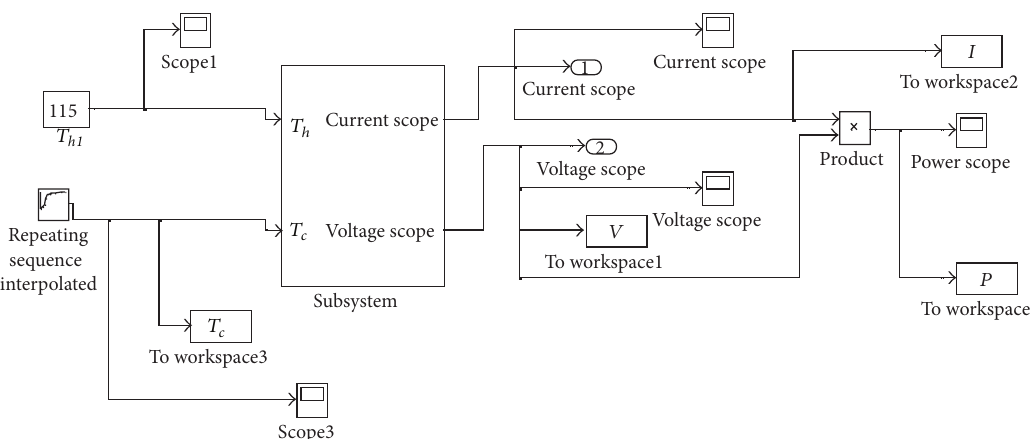
Figure 1: TEM block model as applied in MATLAB.